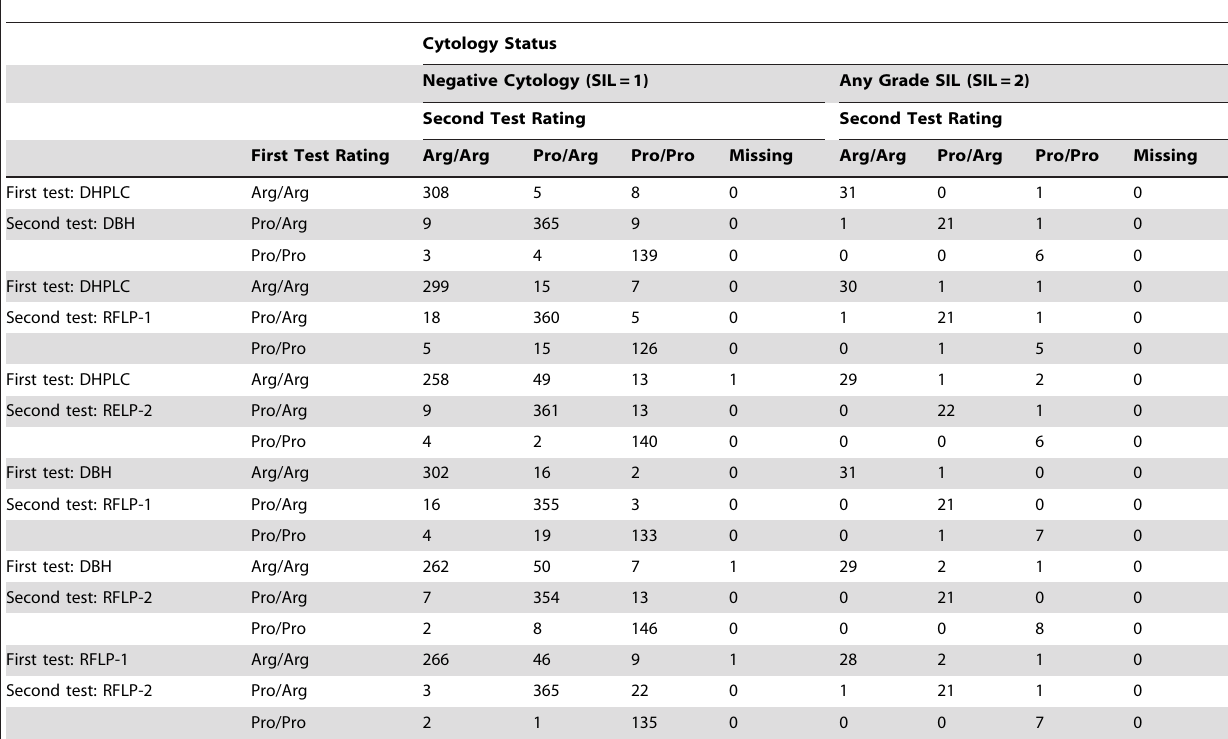
Table 1. Cross tabulation of genotyping test results across four laboratory methods and by cytology status.